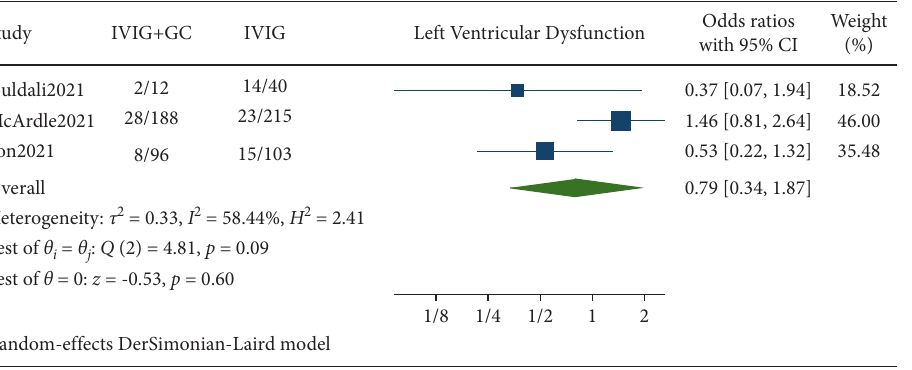
Figure 4: Forest plot showing the comparison of risk of left ventricular dysfunction in IVIG plus glucocorticoids versus